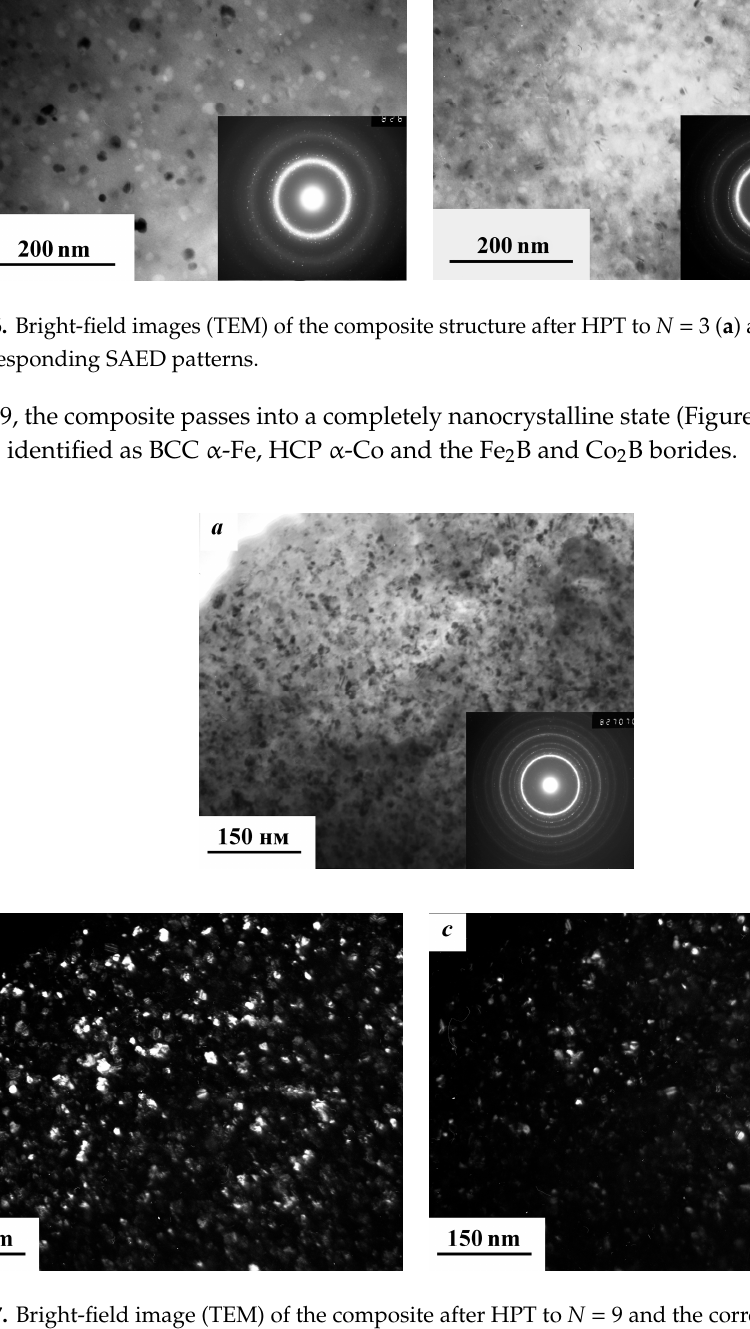
Figure 7. Bright-field image (TEM) of the composite after HPT to N = 9 and the corresponding SAED pattern ( a ); and dark-field images (TEM) from the 1st ( b ) and 4th circles ( c ) of SAED pattern. After small deformation to N = 2, the microhardness HV of the composite decreases by 16% (Figure 8). The minimum HV of the Fe 53.3 Ni 26.5 B 20.2 AA also corresponds to N = 2. The microhardness of the Co 28.2 Fe 38.9 Cr 15.4 Si 0.3 B 17.2 AA decreases progressively over a wider strain range, and HV min is